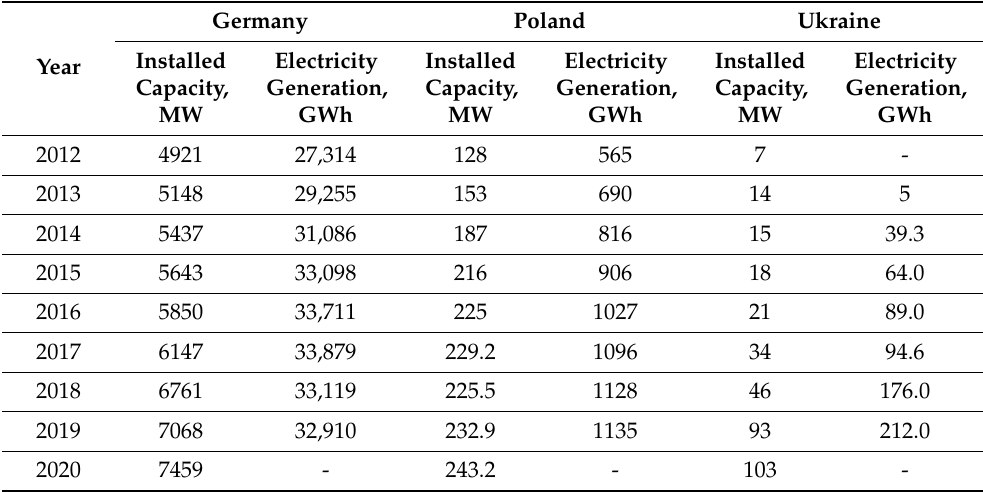
Table 1. Dynamics of biogas production